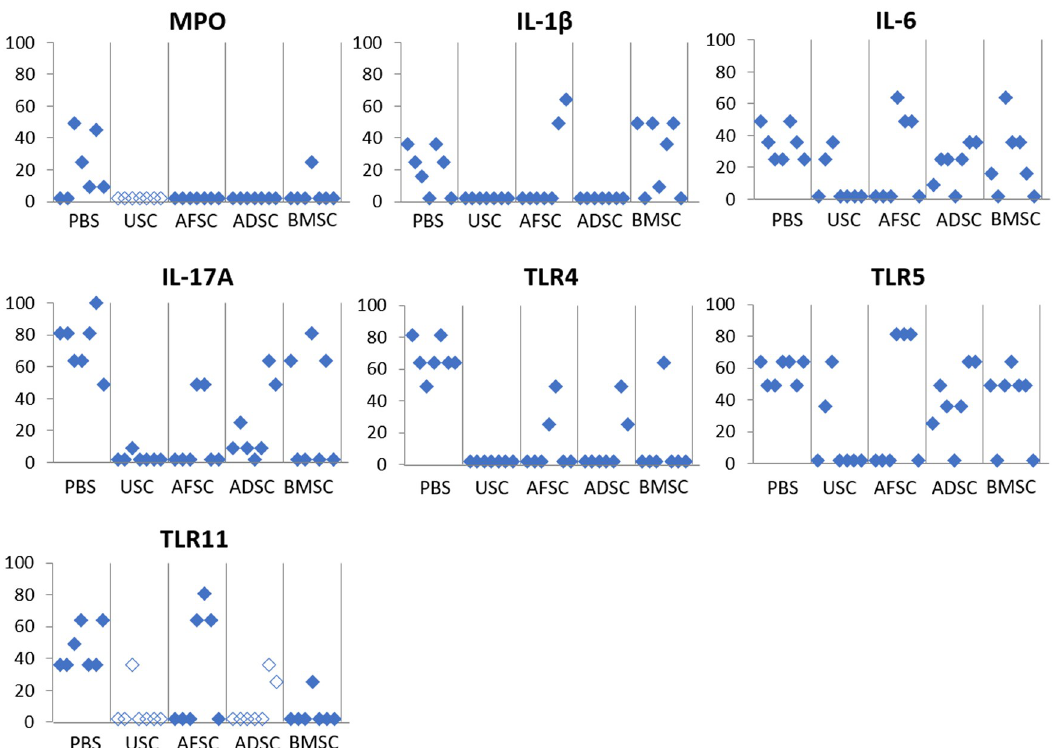
Fig 4. Gene expression results in USC-, AFSC-, ADSC-, BMSC- and PBS-injected groups. USC-injected group showed significantly inhibited expression of MPO, IL-1 β , IL-6, IL-17 α , TLR4, TLR5 and TLR11.